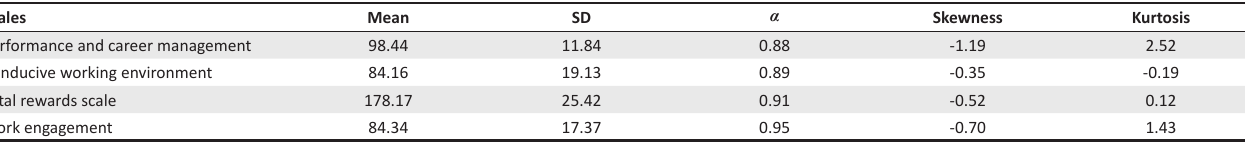
TABLE 2: Descriptive statistics of the reward preference questionnaire. Scales